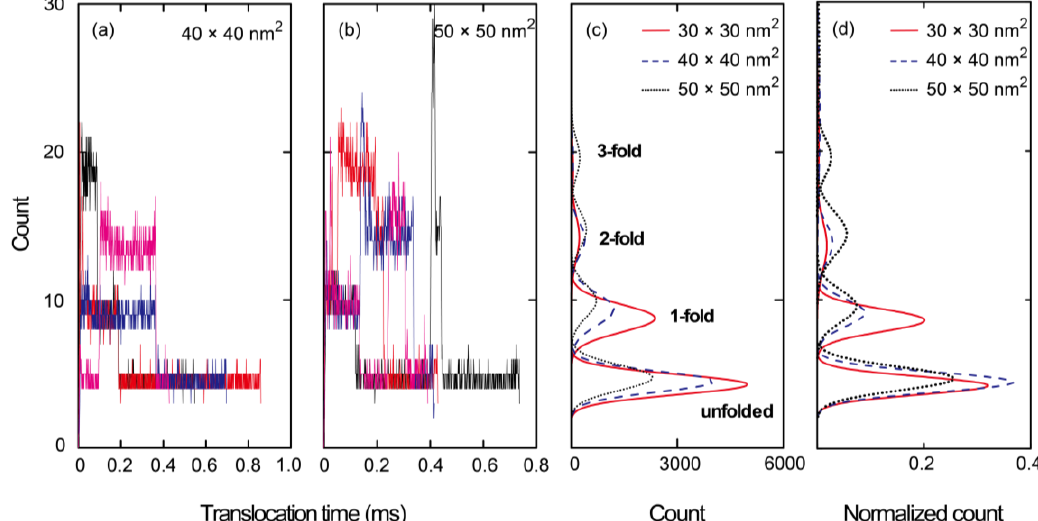
Figure 5. Time series data indicating the number of beads in nanopores of cross-section ( a ) 40 × 40 and ( b ) 50 × 50 nm 2 , in which only four typical data are presented by color variation in each case; ( c ) fitted distribution resulting from the complete data acquired from 20 simulations for each condition; and ( d ) the normalized distribution of ( c